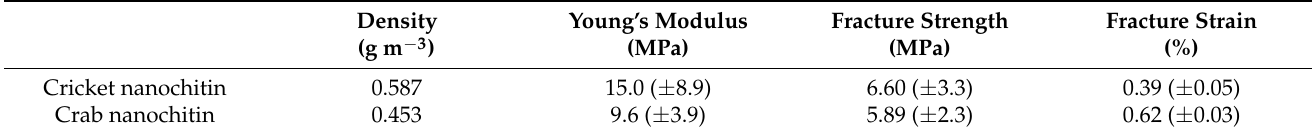
Table 2. Densities and mechanical properties of cricket and crab nanochitin sheet.